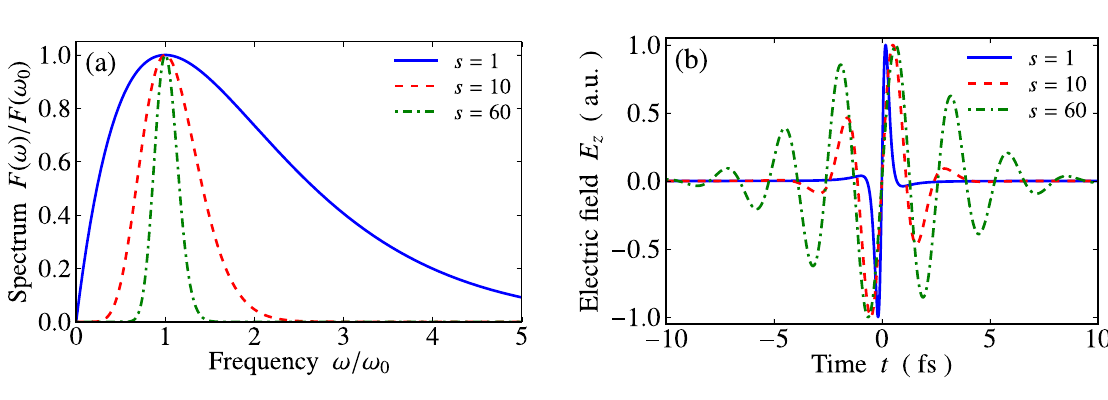
z = 0 . 8 µ m and k = 10 0 0 0